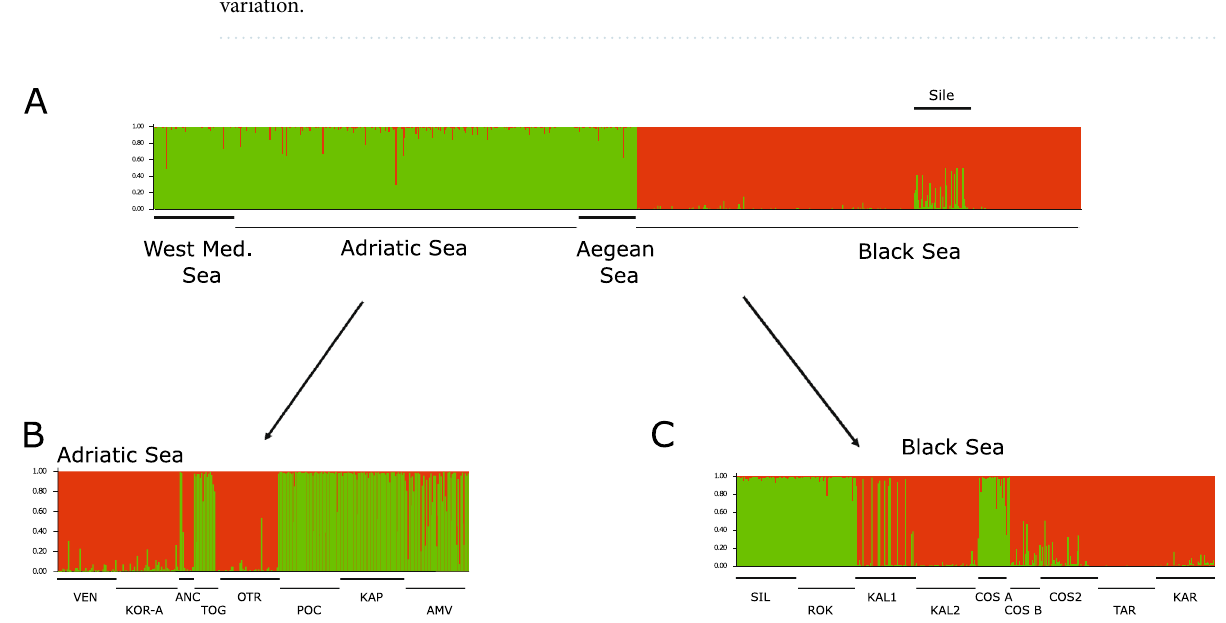
Figure 5. Bayesian clustering analysis showing the most likely partition for: ( A ) the total 786 multi-locus genotypes of Tritia neritea analyzed in this study; ( B ) the Adriatic samples only; ( C ) the Black Sea samples only, without